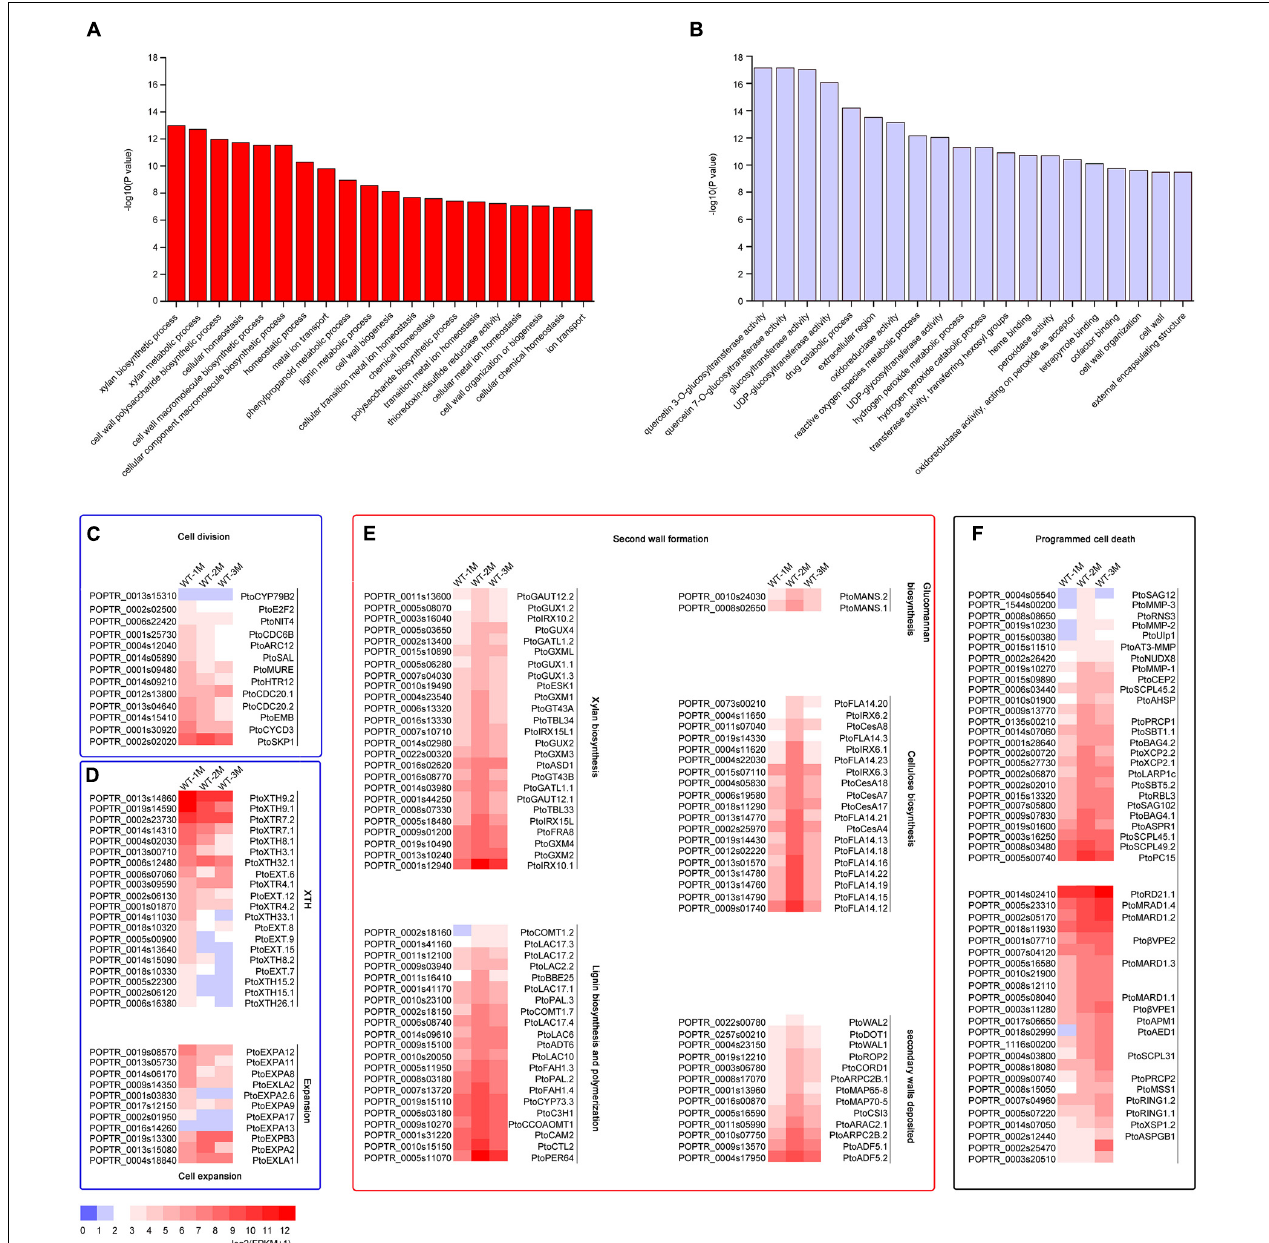
FIGURE 3 | Expression patterns of DEGs involved in cell division, cell expansion, secondary wall thickening, and programmed cell death in poplar xylem. (A) GO enrichment analysis of DEGs in cluster 3. (B) GO enrichment analysis of DEGs in cluster 7. (C) Change in the expression of DEGs involved in cell division during xylem development. (D) Change in the expression of DEGs involved in cell expansion during xylem development. XTH: xyloglucan transglucosylase/hydrolase. (E) Expression profiles of secondary wall genes involved in cellulose, glucomannan, lignin, xylan biosynthesis, and secondary wall deposition during the secondary development of xylem in cluster 3 in Populus . (F) Expression patterns of DEGs involved in cell death during xylem